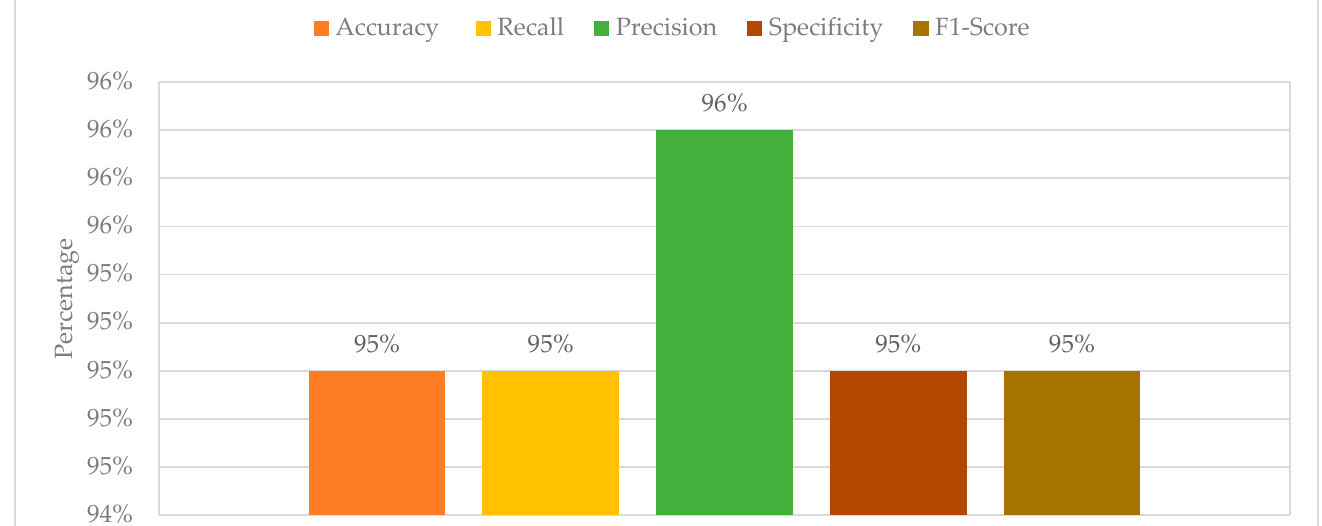
Table 3. Performance comparison for the proposed architecture with existing models.